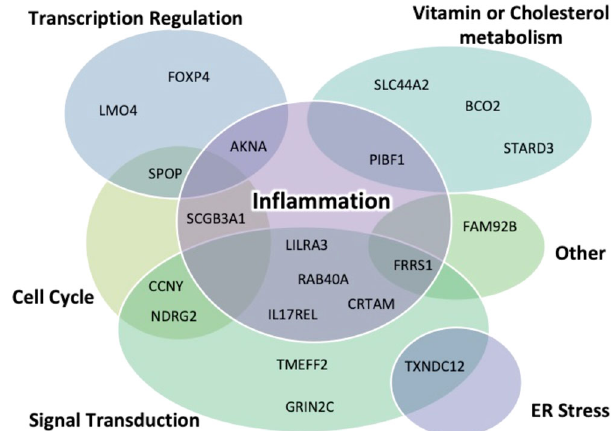
Fig. 2 Venn diagram of the top potential twenty genes predicted. Each gene target was designated to each category after in-depth manual literature review (see Supplementary Table 2). The majority of the predicted MPxgb(AD) genes appear to correlate mostly with innate immunity and signal transduction pathways. Transcription regulation, vitamin or cholesterol metabolism, cell cycle, and ER stress are other pathways the predicted MPxgb(AD) genes show functional associations.